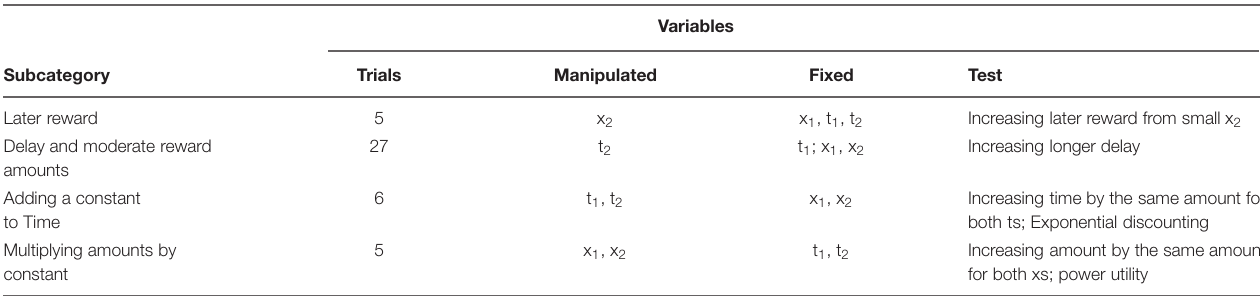
TABLE 2 | Subcategories of trials added to examine different attributes of